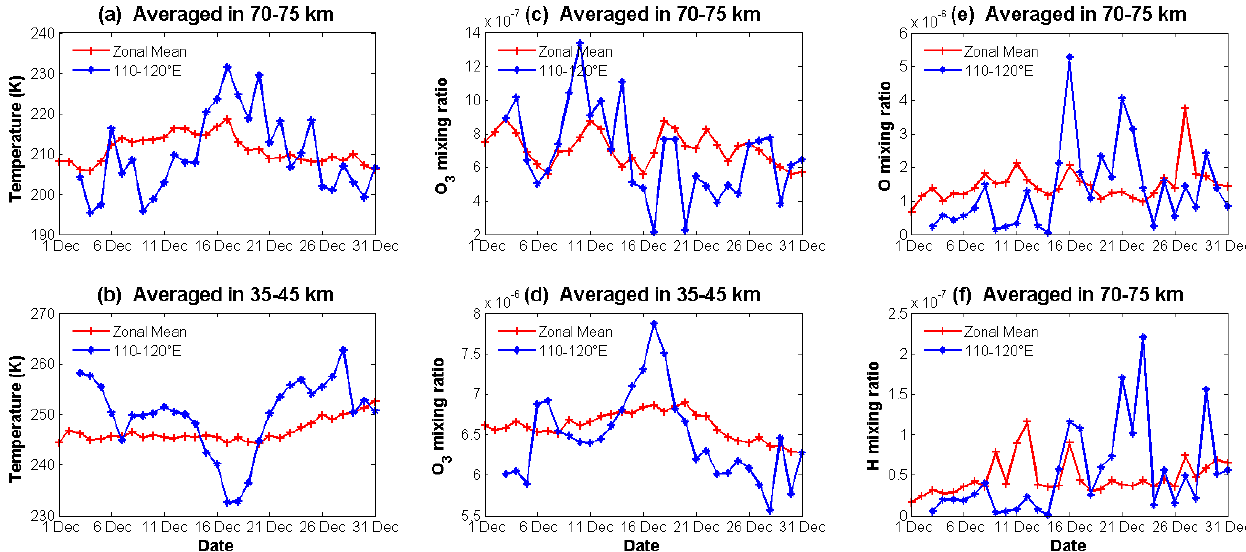
Figure 3. (a, b) Temperature variations in December 2014 from the SABER instrument onboard TIMED satellite, averaged in the altitude range of 70–75 and 35–45km, respectively. (c, d) The same as (a) – (b) but for mixing ratio of O 3 . (e, f) The variations of mixing ratio of atomic H and O in December 2014 from SABER, averaged in the altitude range of 70–75km. The red lines with pluses in each plot represent the daily and zonal mean results averaged between 35 and 45 ◦ N, and the blue lines with asterisks represent the daily mean results averaged near the lidar site (35–45 ◦ N, 110–120 ◦ E).